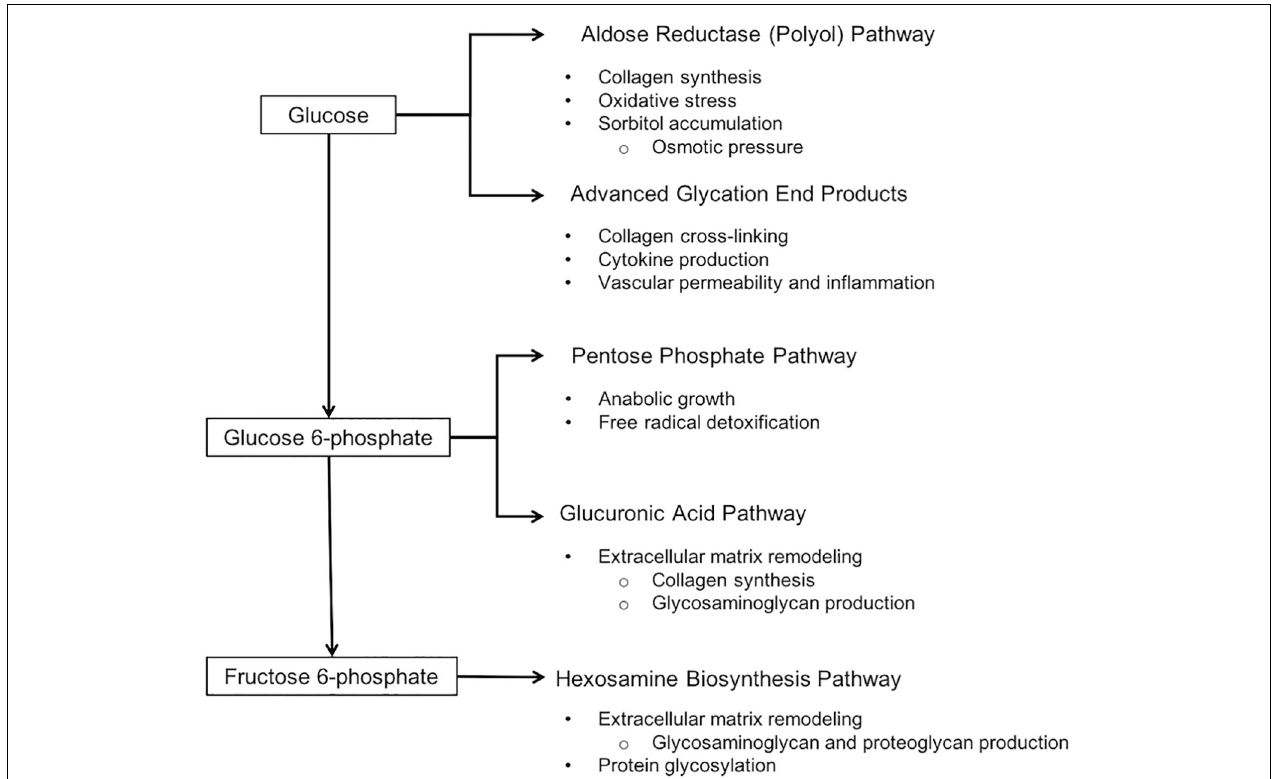
FIGURE 2 | Altered carbohydrate metabolism in wooden breast and relevant effects of each pathway. Wooden breast is associated with a reduced flux of glucose through glycolytic and glycogenic pathways and shunting of glucose into ancillary pathways, including the aldose reductase, pentose phosphate, glucuronic acid, and hexosamine biosynthesis pathways. It has not yet been demonstrated whether or not wooden breast also involves increased synthesis of advanced glycation end